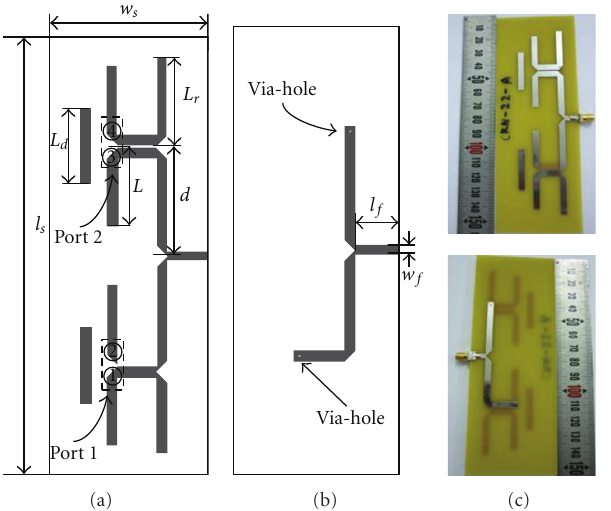
Figure 9: Sketch of the proposed Yagi-Uda antenna array with associated geometrical parameters. (a) Front view. (b) Back view. (c) The prototype of the printed Yagi-Uda antenna array. ( L d = 28mm, L r = 36mm, L = 26mm, S d = 10mm, S r = 18mm, d = 35mm, w s = 58mm, l s = 155mm, w f = 3mm, l f = 10mm).